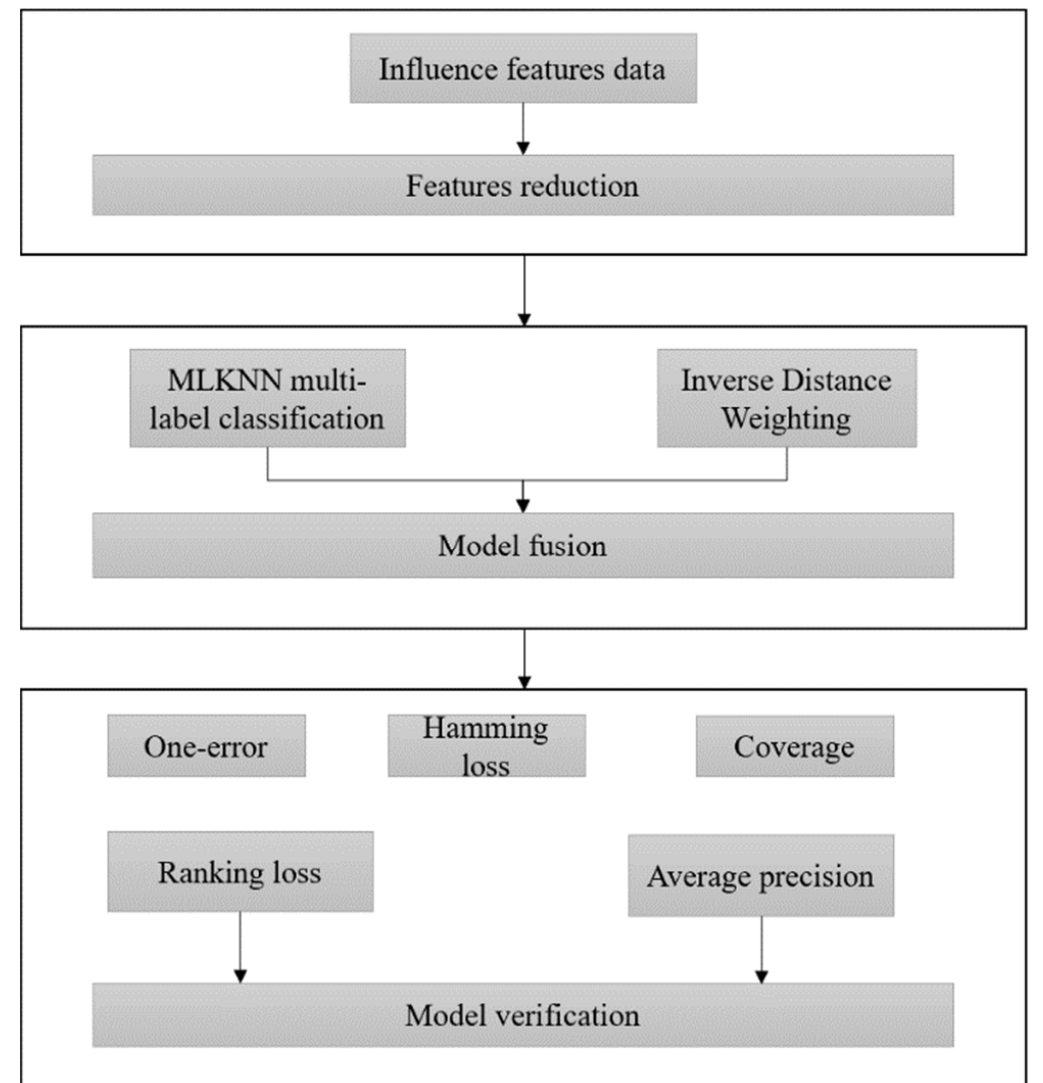
Figure 1. Framework of the proposed method for assessing the types of terrorist attacks.